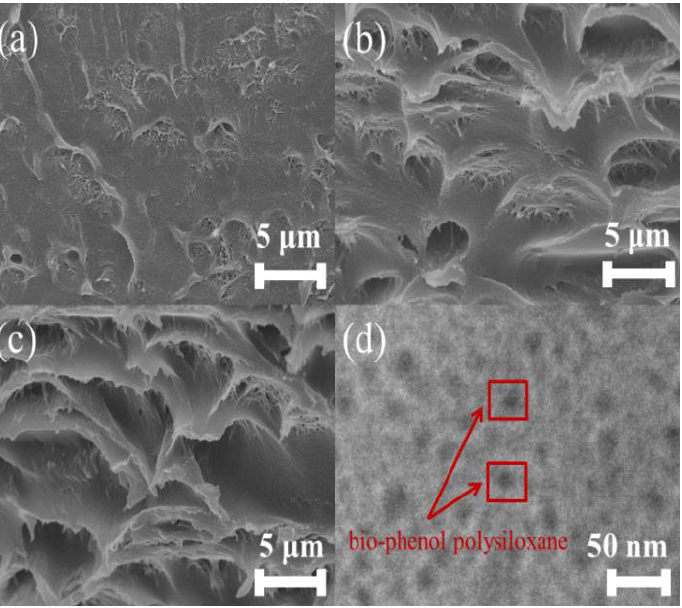
Figure 4. The fracture surface SEM images of 0%Si/PC ( a ), 14%Si/PC ( b ), and 20%Si/PC ( c ); the TEM image of 20%Si/PC ( d ).